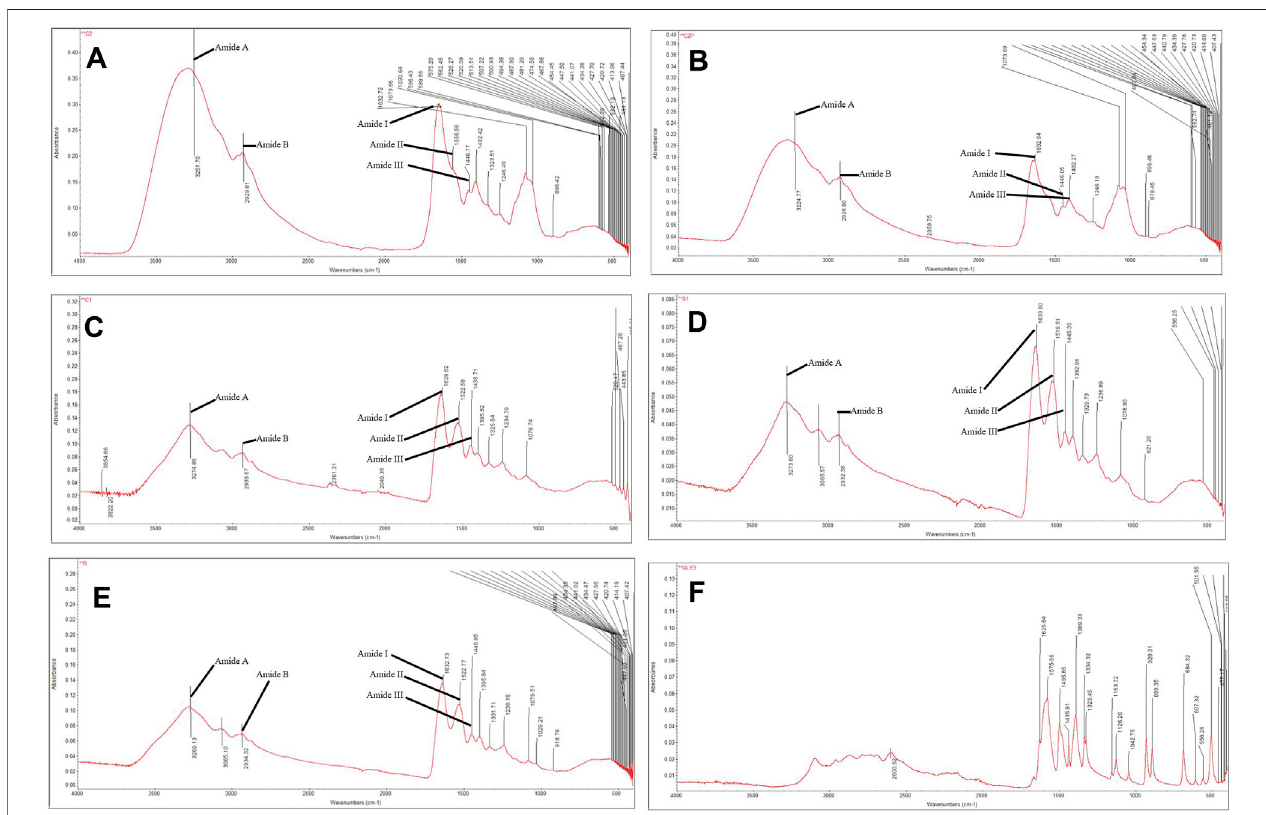
FIGURE 1 | FTIR of (A) Rhopilema esculentum collagen, (B) Rhopilema esculentum collagen, (C) Tilapia Collagen Peptide, (D) Collactive, (E) Matrix Collagen Peptide, (F) Glycine.